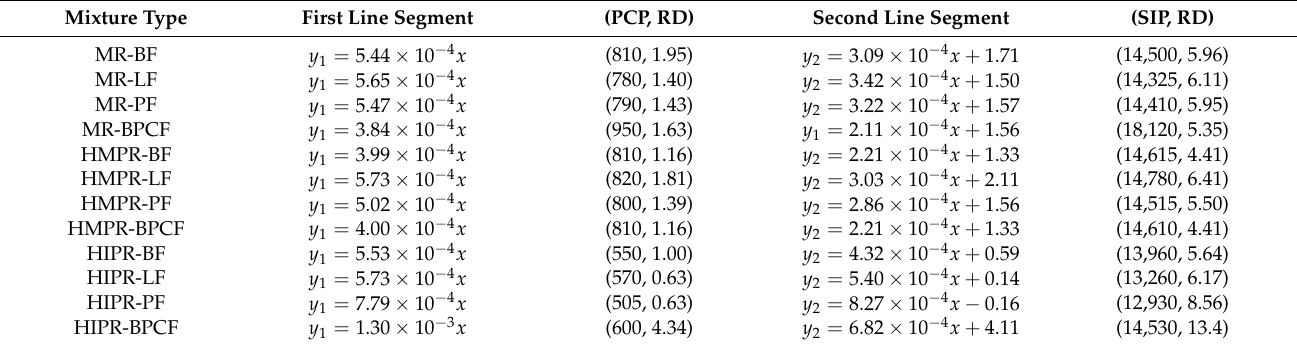
Figure 25. Schematic diagram of PCP and SIP redefinition. Table 12. Line segments and feature points under the new method.